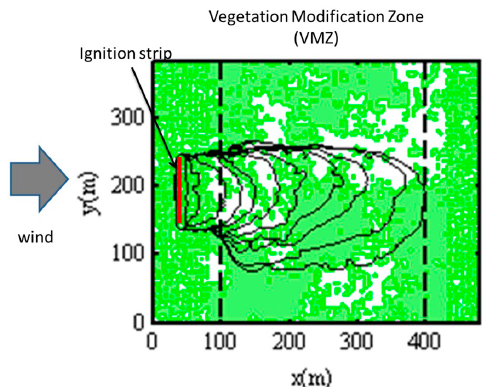
Figure 1. Schematic diagram of the simulation domain with an example simulated forest pattern (green), and an example fire, represented as a series of perimeter contours. The simulation domain measures 480 m in x and 384 m in y. Wind enters the domain from the left side of the figure and proceeds to the right. After initial wind field development, a fire is initiated at the location of the ignition strip. Fire metrics used in analysis are calculated over the 300 m length between x = 100 m and x = 400 m.